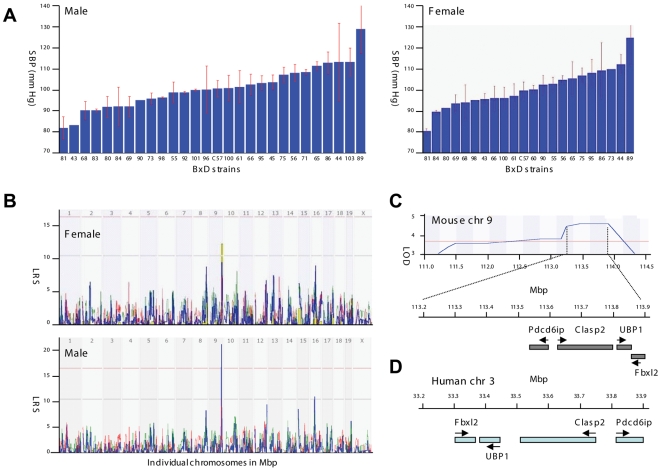
Mapping of a systolic blood pressure (SBP) quantitative trait locus (QTL) in BXD strains.(A) Rank ordered mean BP values across 27 male and 21 female BXD strains (with SEM error bars). (B) In males, a significant BP QTL is mapped on chromosome 9. In females, BP QTL maps to the same region on chromosome 9. (C) The genomic region corresponding to the BP QTL on chromosome 9. The LOD score is depicted in blue with the highest values at the position 113.2 to 113.9 Mb achieving LOD of 4.7. Individual genes under the BP QTL peak are indicated. (D) The syntenic chromosomal region in human.